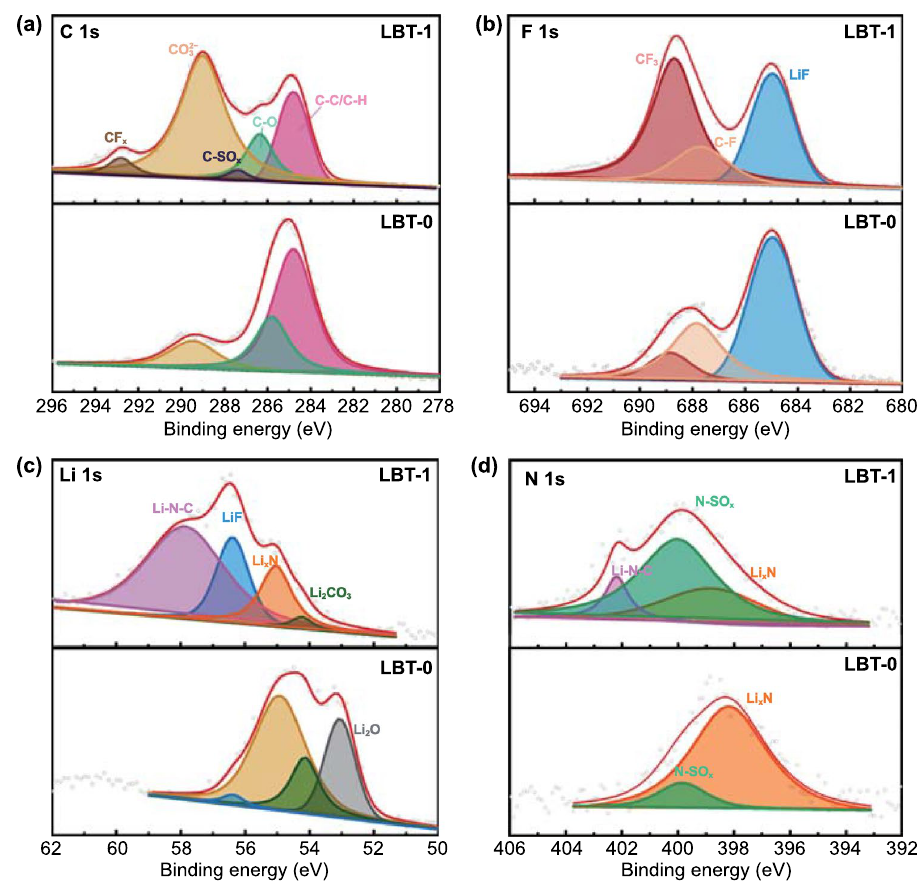
Fig. 5 XPS spectra of a C 1s, b F 1s, c Li 1s, d N 1s of the Li anodes after 10 cycles in LBT-0 and LBT-1